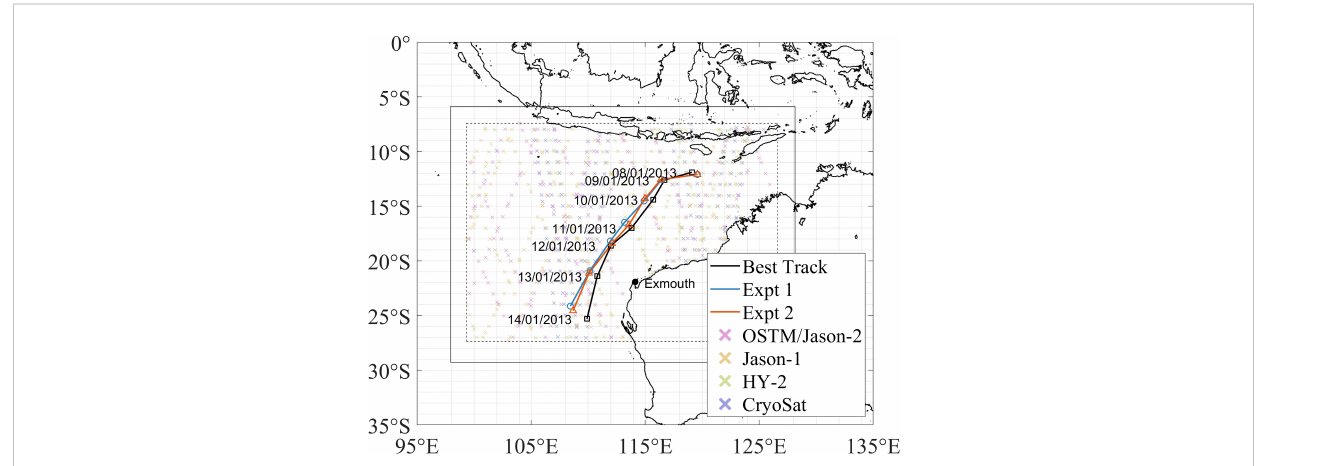
FIGURE 1 Domain of the COAWST model. The inner domain outlined by dashed lines (ROMS and SWAN) is nested with the outer domain outlined by solid lines (WRF). The best-track observations and the track of TC Narelle modeling without and with the spume scheme are represented in solid black lines with squares, solid blue lines with circles, and solid red lines with triangles, respectively. The passage points of satellites are represented by cross